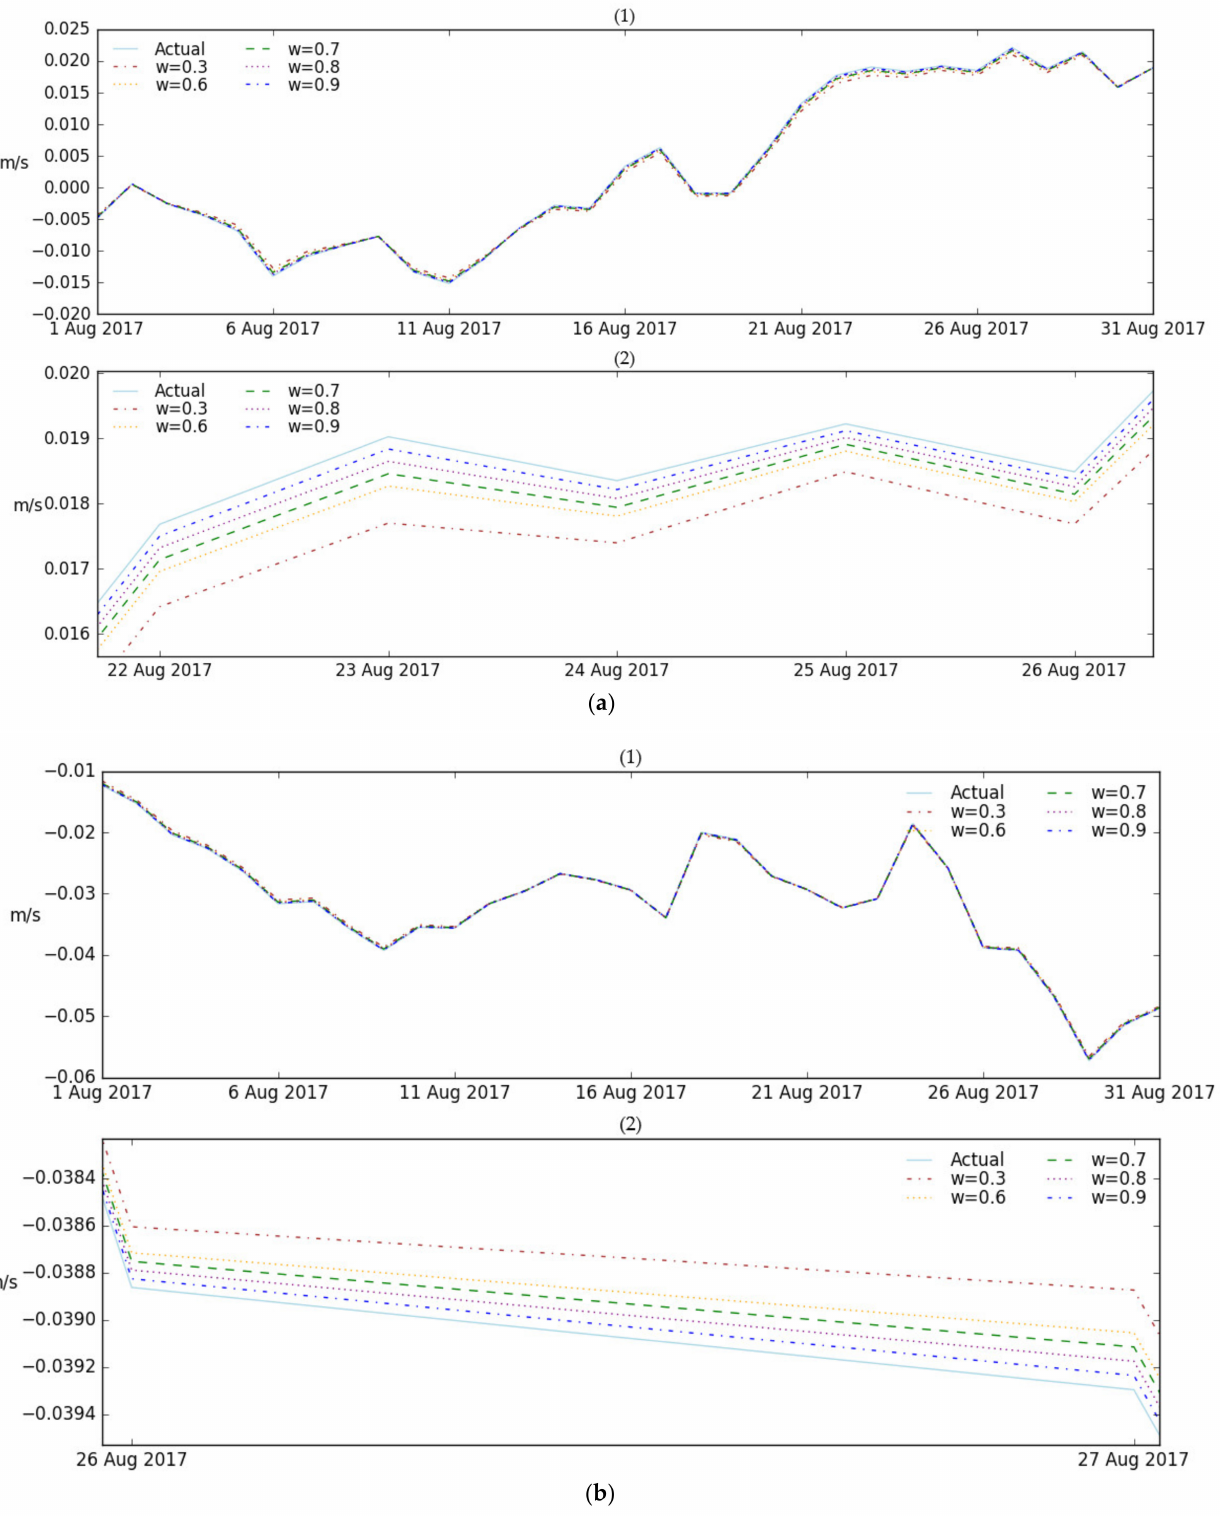
Figure 10. The comparison between the predicted OCs and observed OCs with different ω for spatial point (129.875 ◦ E, 29.5 ◦ N)—( a ) u_current, ( b ) v current. The subfigure (1) is the comparison result for August 2017. In order to clearly see the performance differences for different ω , we select several days from August and show the comparison results in subfigure